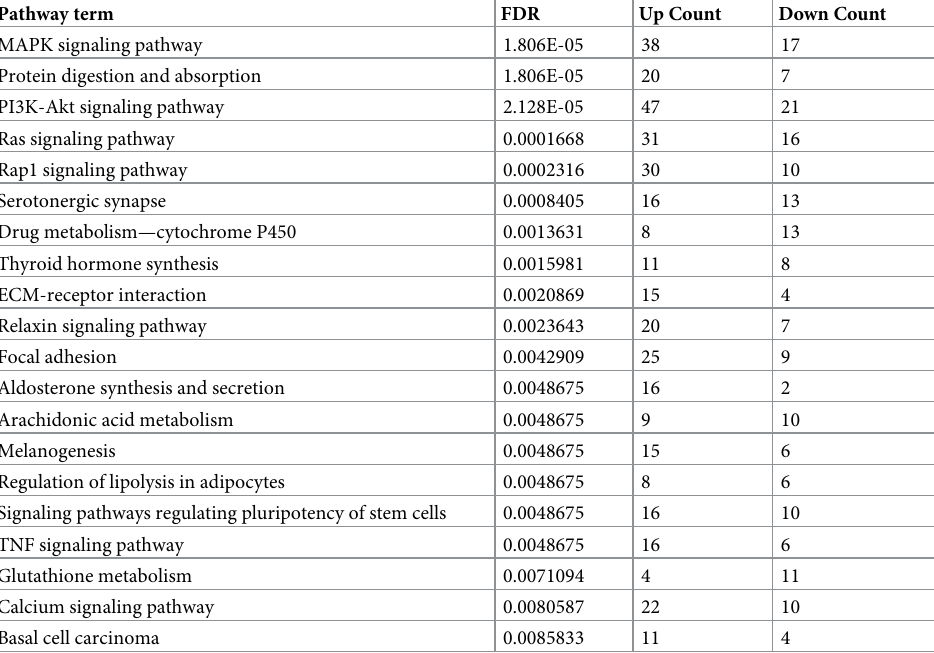
Table 4. KEGG pathway analysis of